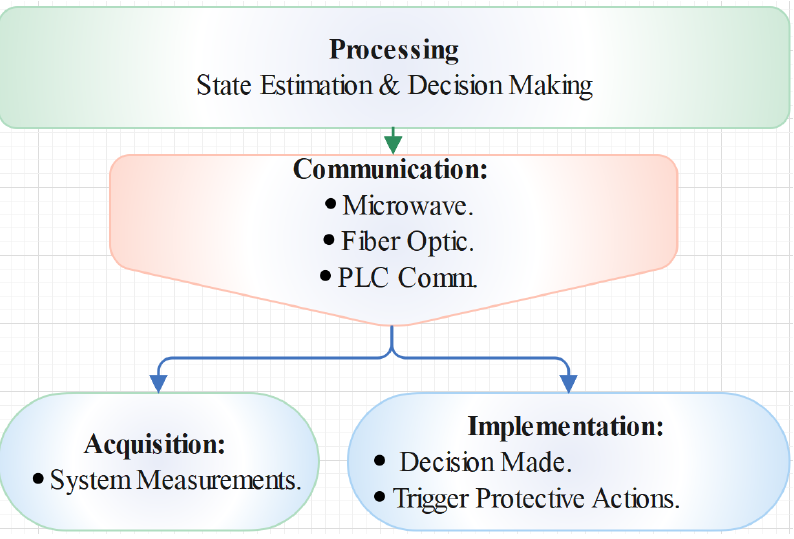
Figure 2. ICT Categories in Power